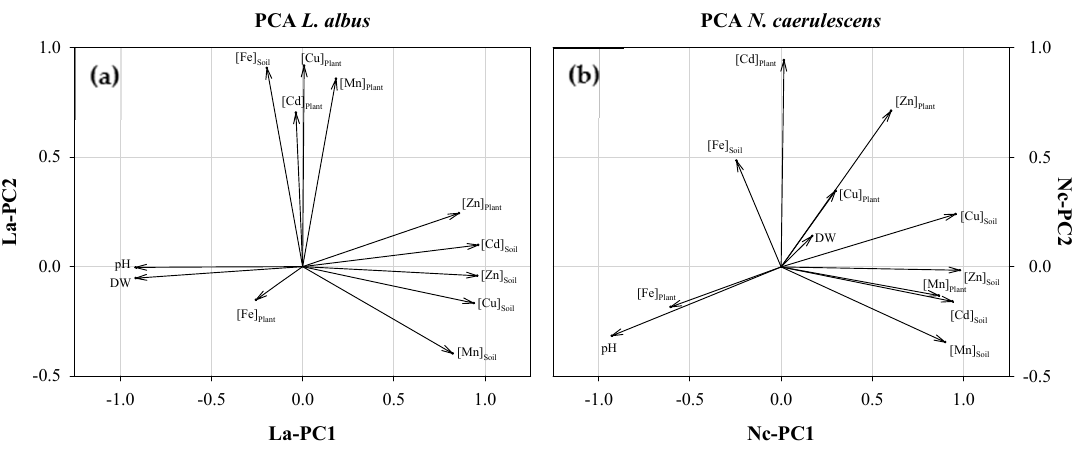
Figure 5. Principal component analysis of the data corresponding to the individual cultivation and cocultivation of L. albus ( a ) and N. caerulescens ( b ) plants in Experiment 2.